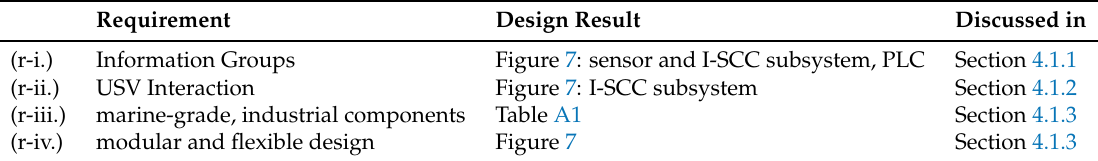
Table 1. Resulting I-SCC design based on the design requirements of Section 3.2.